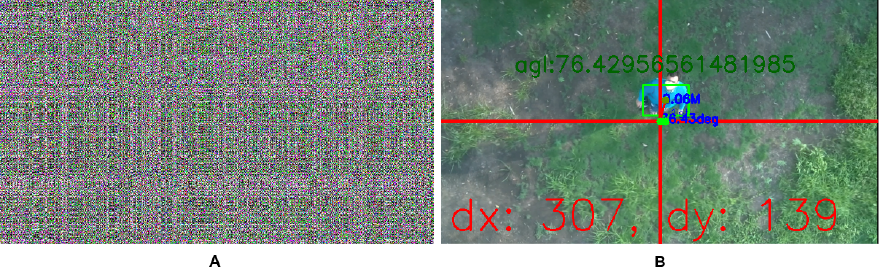
Figure 14. Results of image encryption ( A ) and decryption ( B